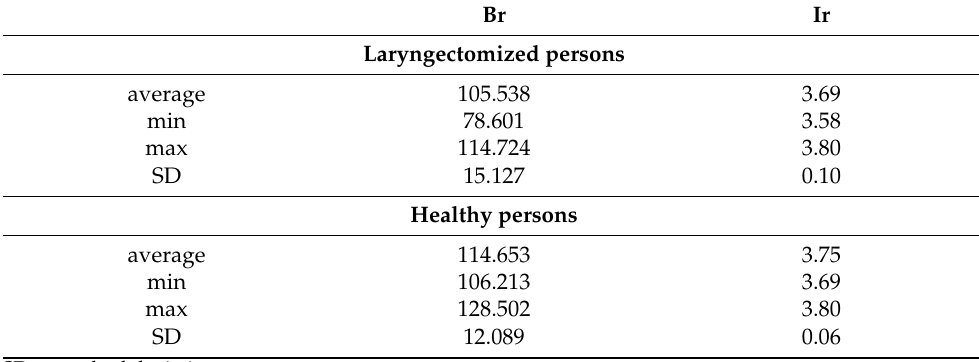
Table 9. The second phonetic segments „cz”—descriptor values—the word “paczka”.